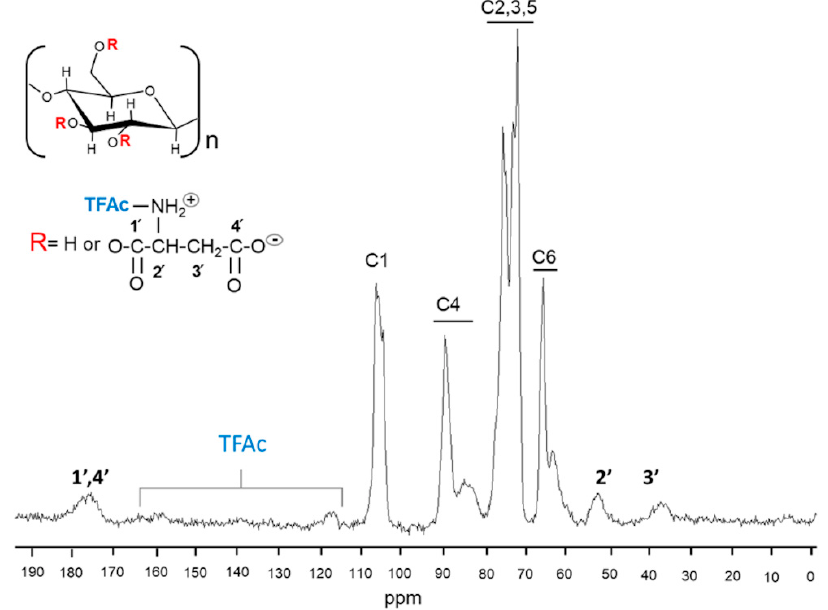
Figure 3. Carbon 13 by cross polarization magic angle spinning ( 13 C CPMAS) Nuclear Magnetic Resonance (NMR) spectrum of cellulose modified with N-trifluoroacetyl-L-aspartic anhydride (Cel-Asp-N-TFAc).